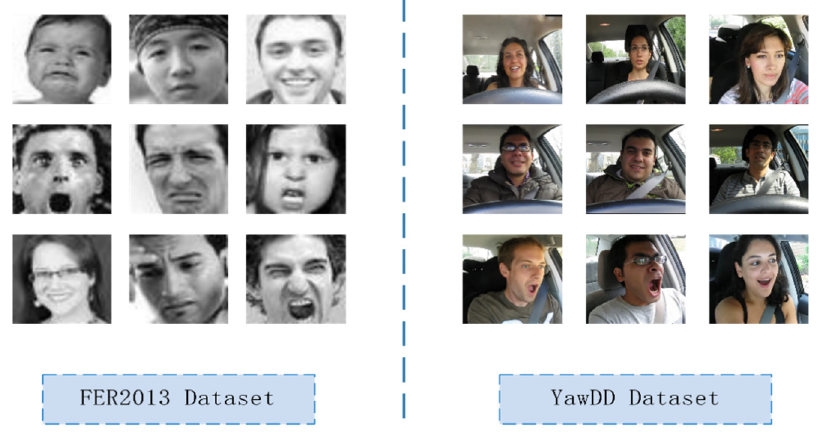
Figure 11. Fer2013 and YawDD datasets.